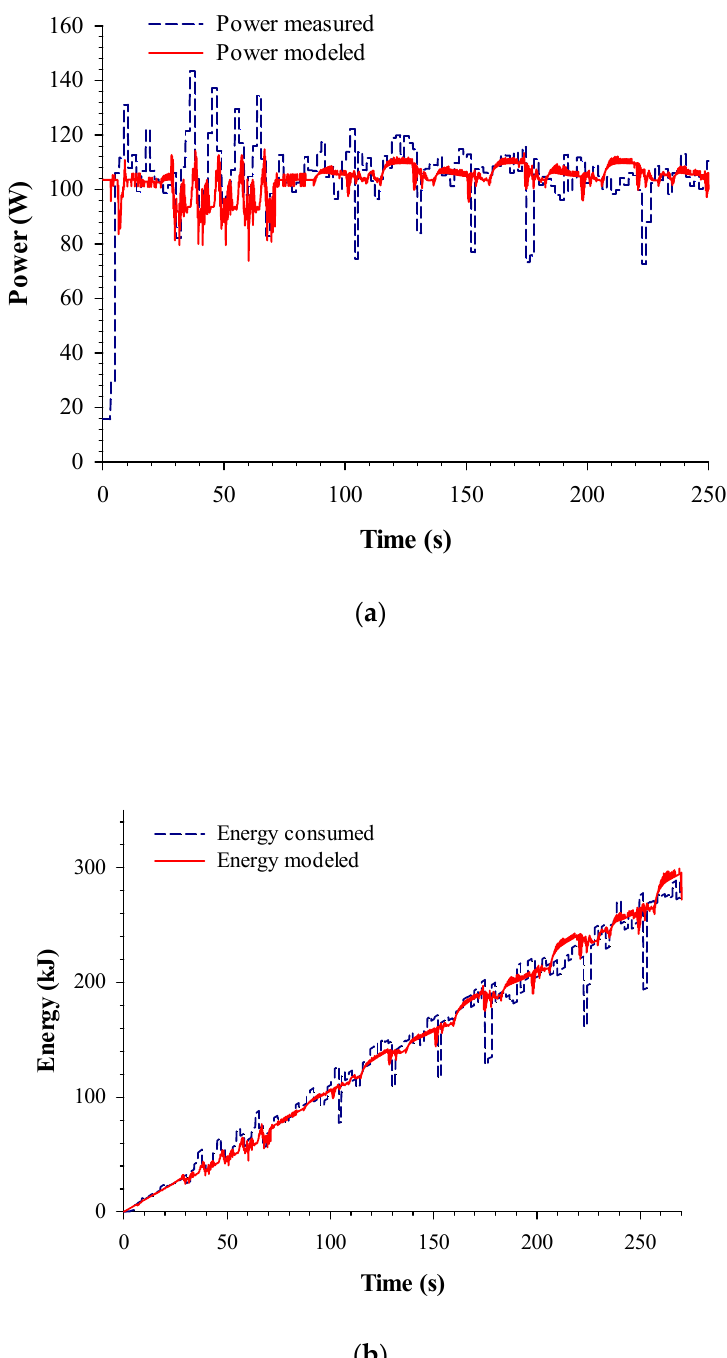
Figure 13. Measured and modeled ( a ) power and ( b ) energy consumption for the DJI Mavic